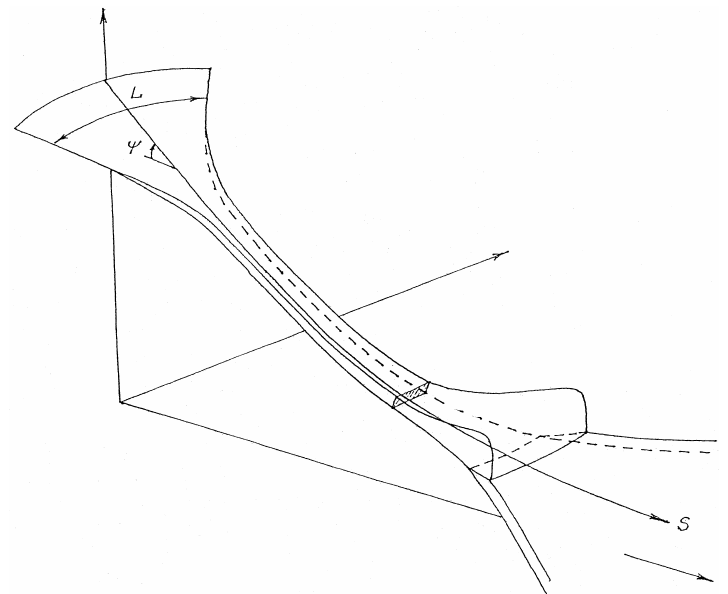
Figure 1. Schematic representation of an avalanche flowing in a rectangular channel of variable width L ( S ) , with S the coordinate along the centerline of the path and ψ ( S ) the local slope